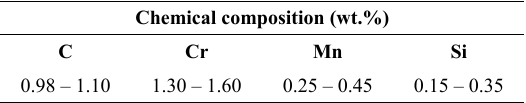
Table 1. Chemical composition of the samples.